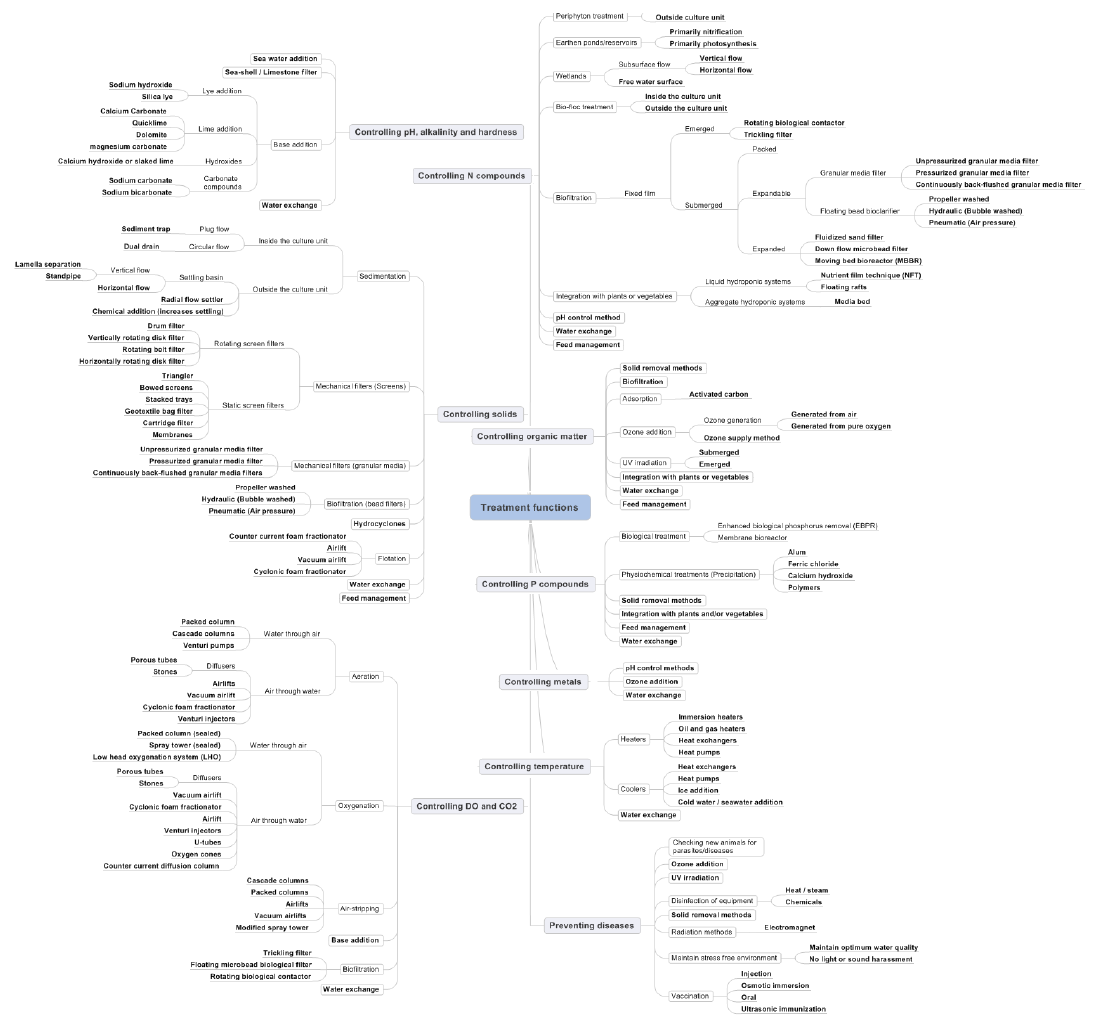
Figure 15. Taxonomy of the technical solutions of the treatment